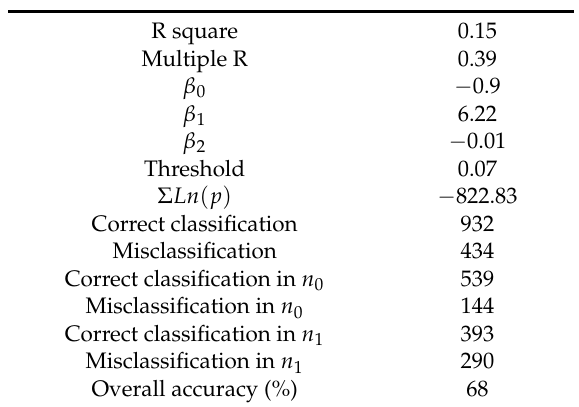
Table 2. Summary of the logistic discriminant analysis of the independent variables ( ∆ γ and H) and dependent variables (categories 0 and